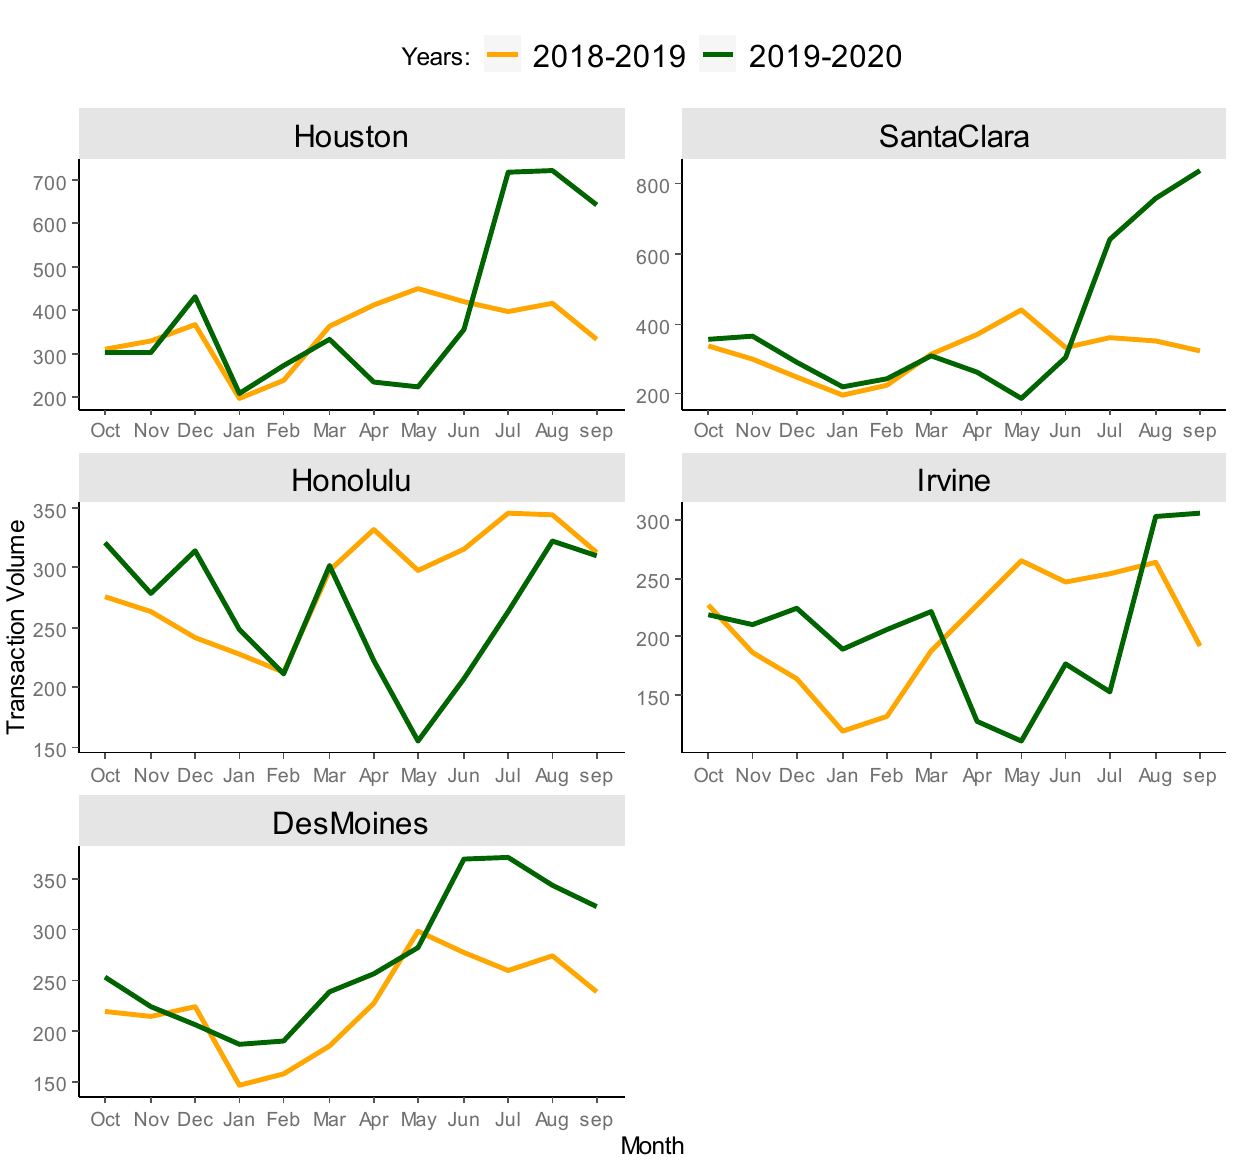
Figure 1. Median House Prices and Transaction Volumes.